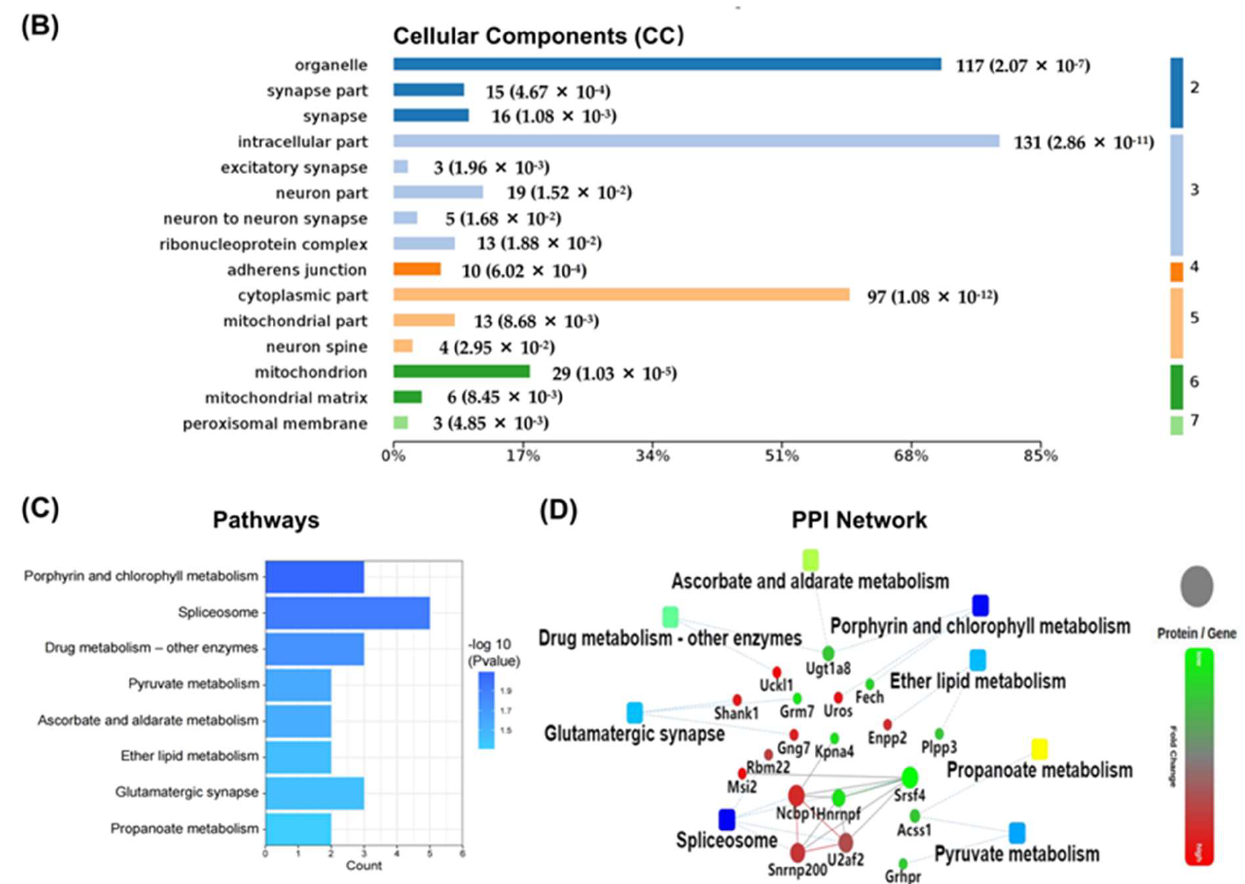
Figure 3. Bioinformatics analysis of the differentially expressed proteins in the As/Ctrl group. ( A ) The top 15 categories of enriched BP associated with DEPs. ( B ) The top 15 categories of enriched CC associated with DEPs. ( C ) The significantly enriched KEGG pathways linked to DEPs. ( D ) Pathway PPI network linked to the differentially expressed proteins in the As/Ctrl group. ( A – C ) The number of proteins and p values associated with each category is shown to the right of each term bar.